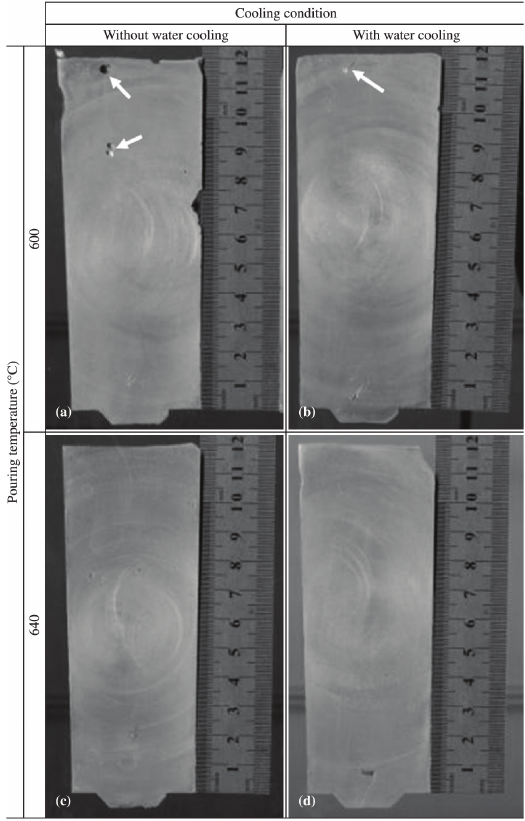
Figure 4. Typical macrograph of the longitudinal cross-section of ingots produced using CS casting with and without water-cooling and different pouring